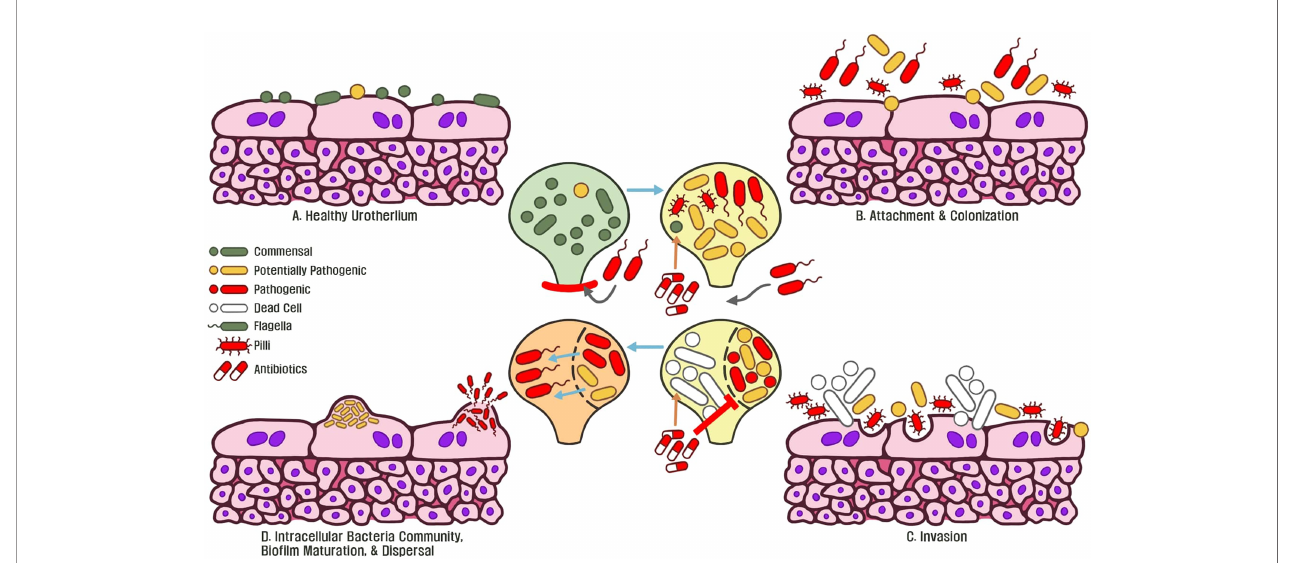
FIGURE 3 | (A) Commensal microbiota are associated with a healthy normal human urothelium and protect the host from invasive pathogens. (B) An initial course of antibiotics enforces bacteria to express fl agella, type 1 pili, and adhesin proteins to attach and colonize the urothelium. (C) Continued antibiotic exposure eliminates commensal bacteria and surviving microbiota exposed to this stressor become resistant. Invasive bacteria begin to express virulence genes to colonize and replicate within tissue. (D) Following replication, intracellular bacteria communities are formed and antibiotic resistant bio fi lms become matured. Continued exposure to stressors such as antibiotics allows for the emergence of pathogenic, MDR bio fi lms, which underlines recurrent chronic UTIs of the